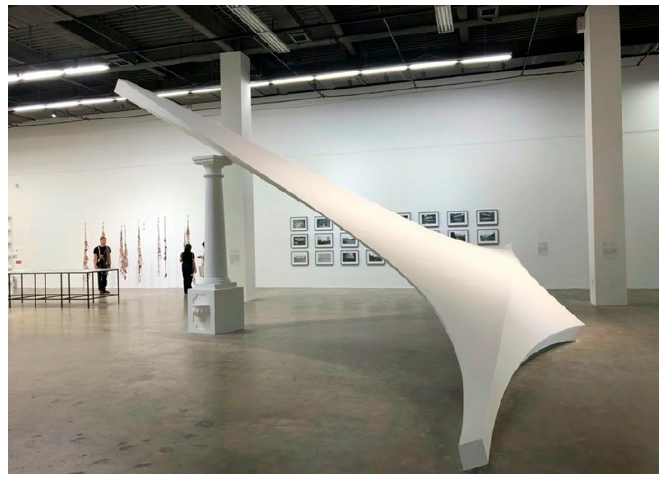
Figure 1. Lais Myrrha, Estudo de Caso [Case Study] , 2018, replicas 1:1 of columns in plaster, Gwangju Biennale, courtesy of the artist.